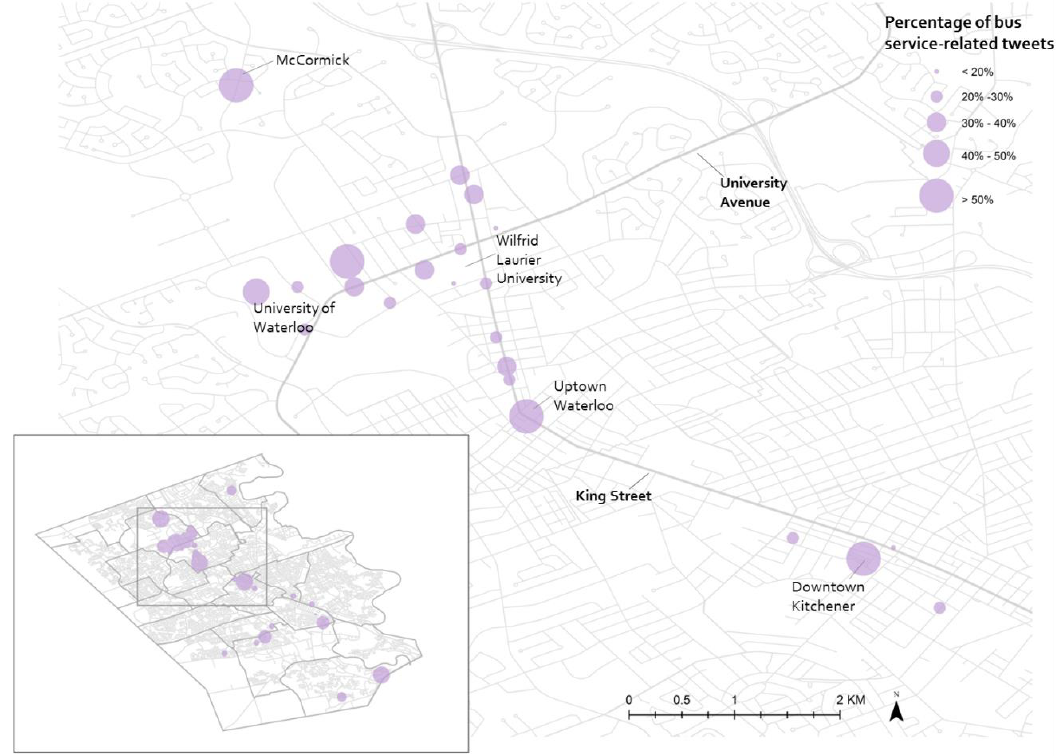
Figure 10. Spatial clustering of bus service-related tweets.